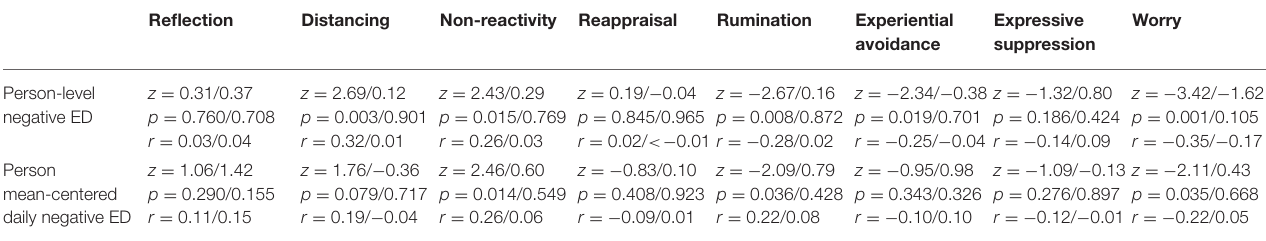
TABLE 7 | Results from separate multilevel models evaluating the association between daily emotion regulation strategies as a categorical measure (present or not present) and person-level and person mean-centered daily negative emotion differentiation (ED) (without/with daily negative emotions as a covariate). Reflection Distancing Non-reactivity Reappraisal Rumination Experiential